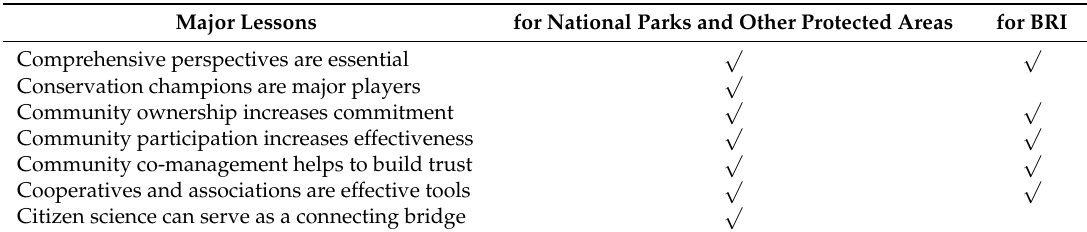
Table 2. Lessons learned from recent conservation history in the Sanjiangyuan region,